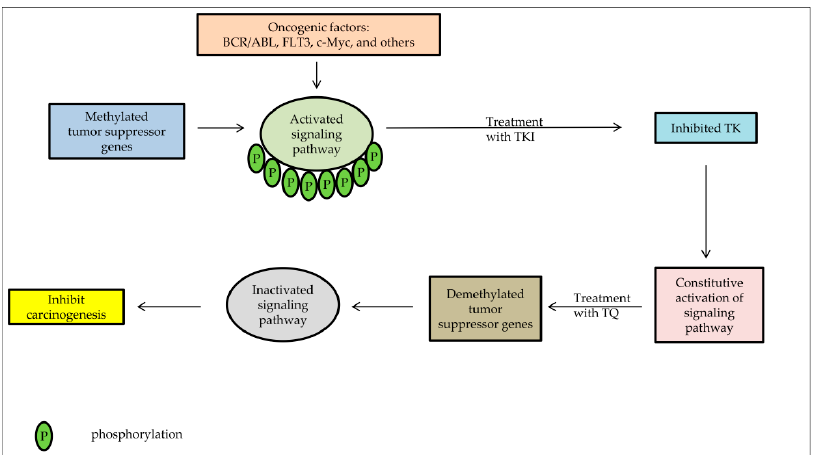
Figure 4. The effect of TKI and TQ treatment combination on cancer cells. In the absence of TSG-negative regulation due to hypermethylation, there will be constitutive activation of signaling pathways even though TKI has inhibited TK, resulting in resistance to TKI. However, after treatment with TQ, there will be reactivation of Tumor suppressor genes (TSG) resulting in inhibition of signaling pathways leading to suppression of cancer cell proliferation.